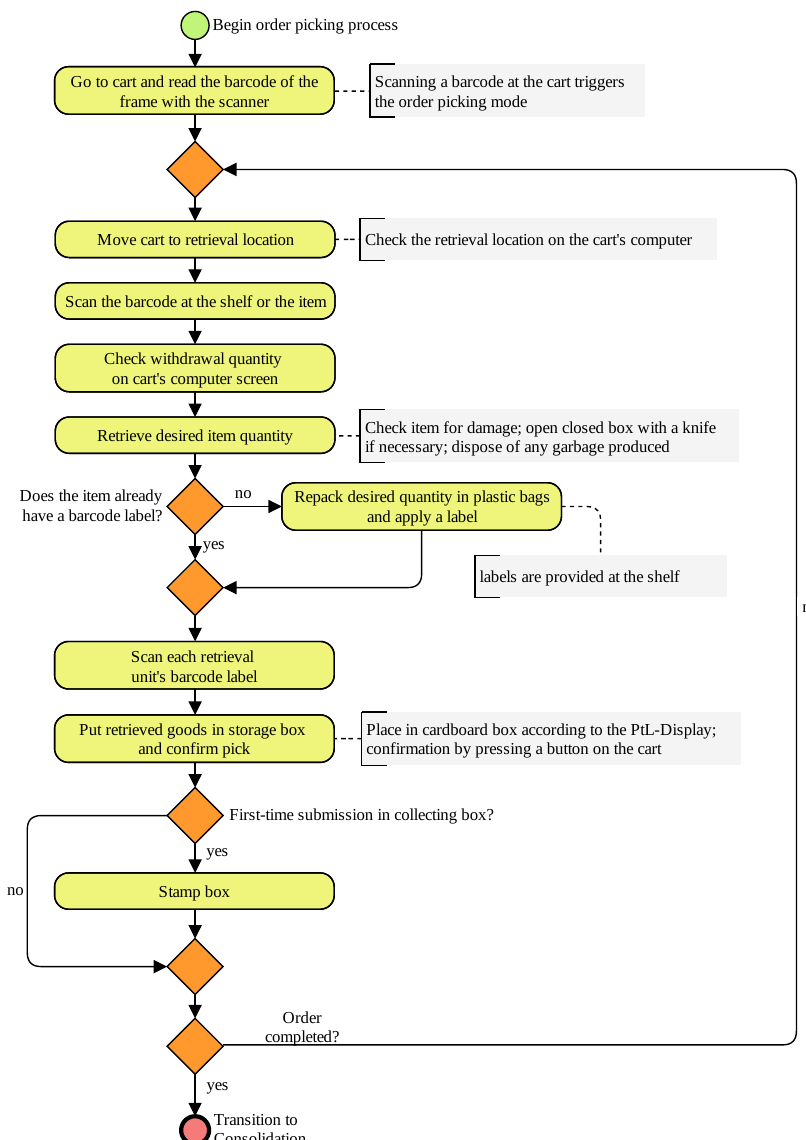
Figure 3. Business process model of logistics Scenario 2 (Part 1)—real warehouse order